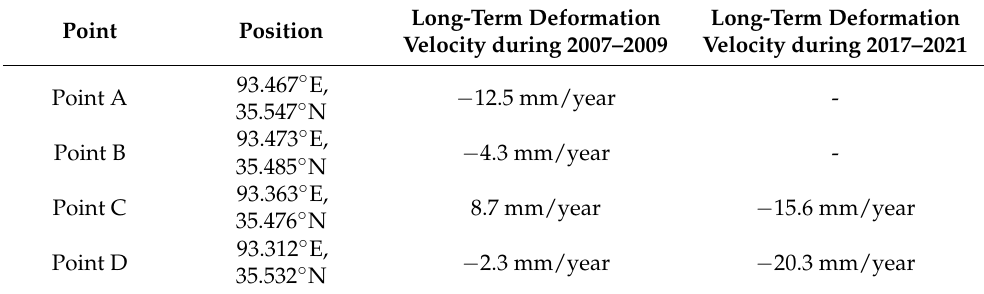
Table 4. The details of the four selection points around Salt Lake.